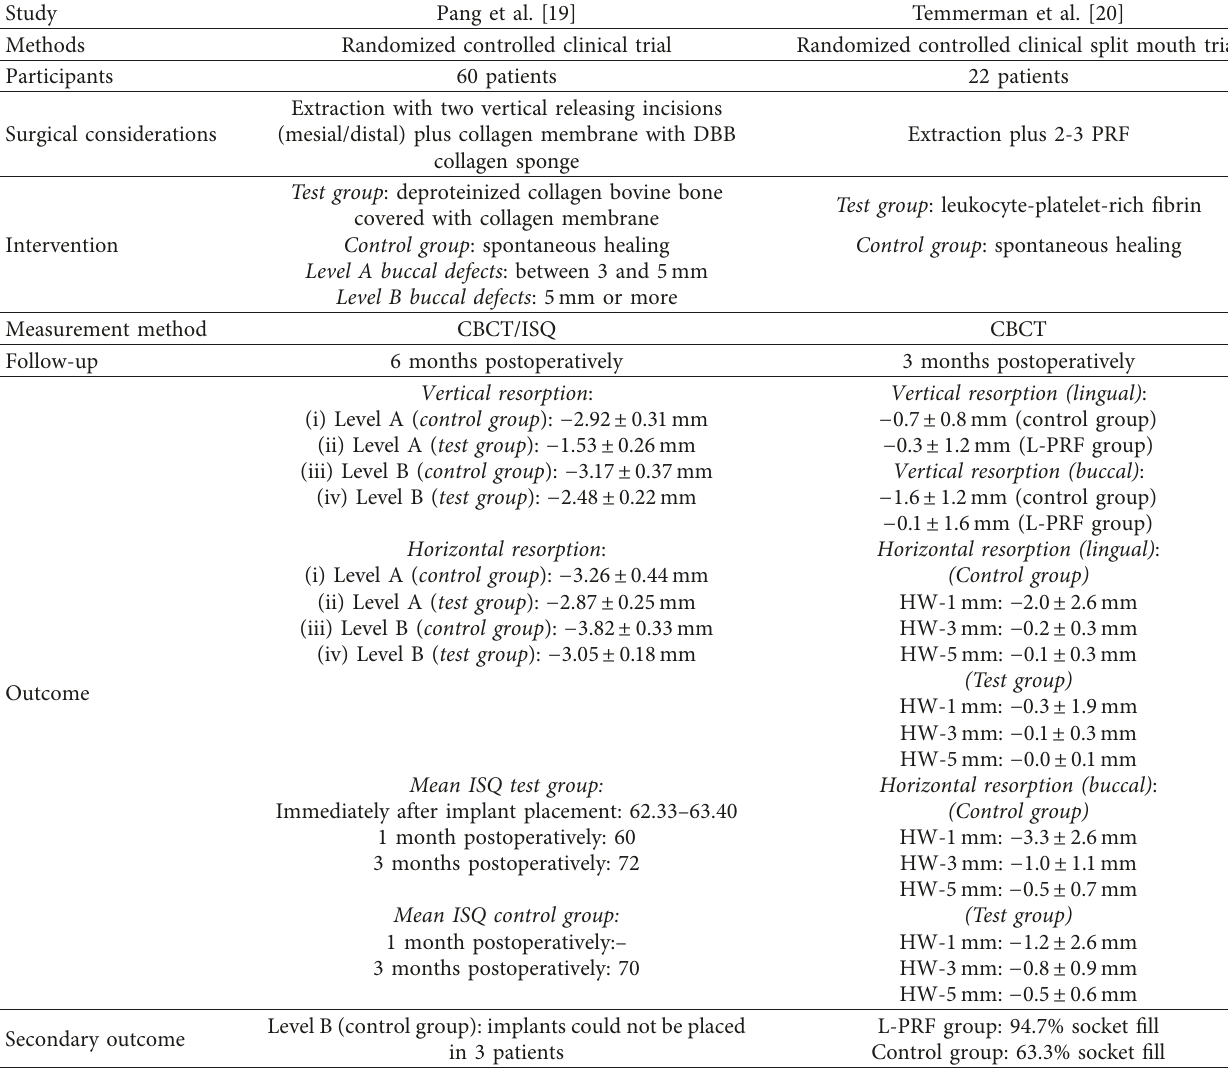
Table 1: The studies included in the final